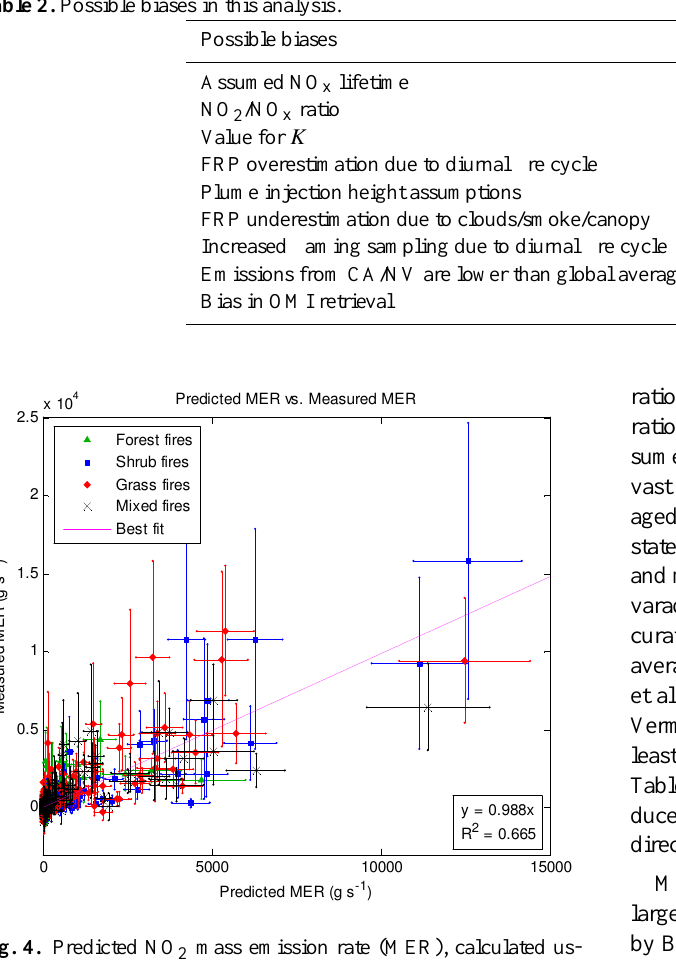
Fig. 4. Predicted NO 2 mass emission rate (MER), calculated us- ing fire radiative power and the multiple regression coefficients, vs. MER measured in the analysis. Error bars in measured MER are one standard deviation, calculated as reported; error bars in pre- dicted MER are calculated using one standard deviation of each calculated emission